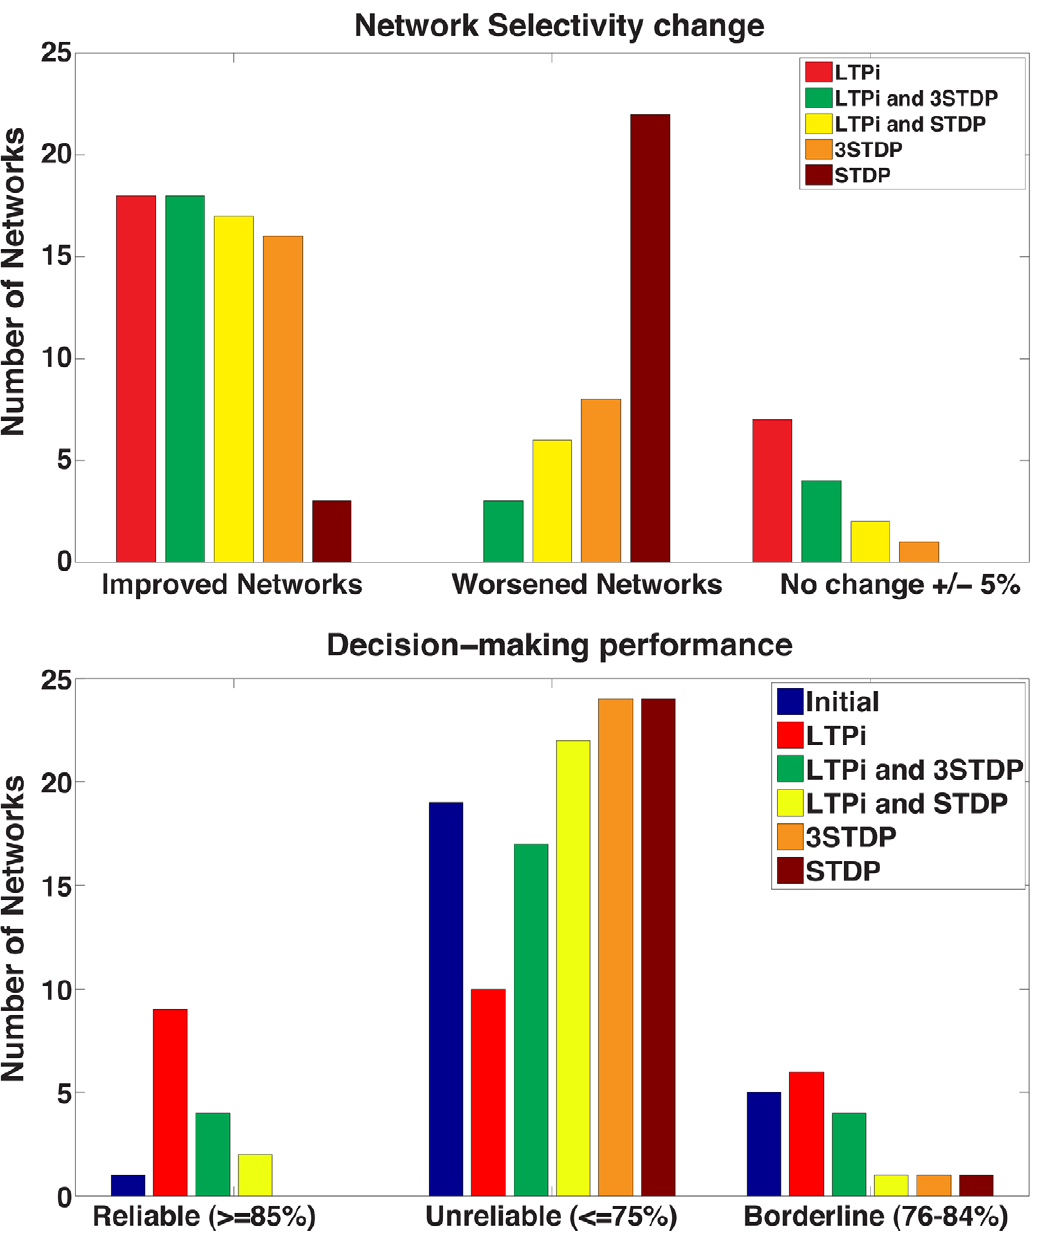
Figure 8. Summary of network stimulus-pair selectivity and decision-making performance. Top: Network change from initial conditions. Networks are classified as improved ( Left ) or worsened ( Middle ) if stimulus-pair selectivity increased or worsened, respectively, by more than 5%. If mean selectivity remained within 5% of its initial value, then the network’s stimulus-pair selectivity change is defined as unchanged ( Right ). LTPi alone produced the most improved networks (15/25), and did not produce worsened networks. Networks with LTPi and either triplet or standard STDP produced more improved networks and fewer worsened networks than the networks with the same STDP but without LTPi. Bottom: Summary of network decision-making performance with a criterion threshold of 85% correct. Left : One network generated reliable decisions without plasticity. The remaining networks each require LTPi to make reliable decisions. Middle : Initial, standard, and triplet STDP networks dominate making unreliable decisions ( # 75%), while LTPi alone has the fewest unreliable networks. Right : Borderline networks in the range of 76– 84%. Note that performance up to 75% can be achieved without information based on stimulus-pairs.